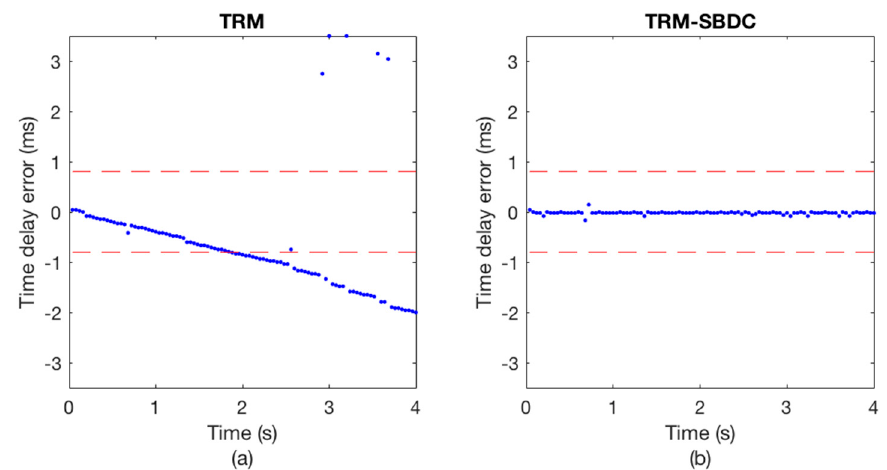
Figure 15. The Doppler time delay error when the sending boat is drifting. ( a ) TRM; ( b ) TRM-SBDC.